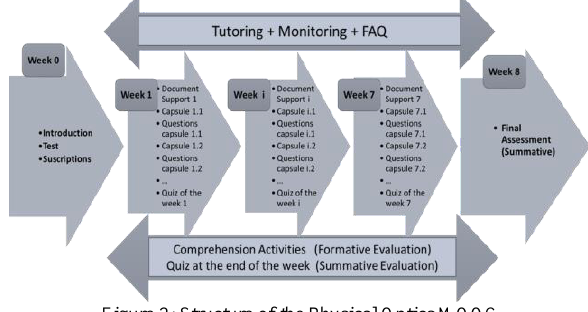
Figure 2: Structure of the Physical Optics